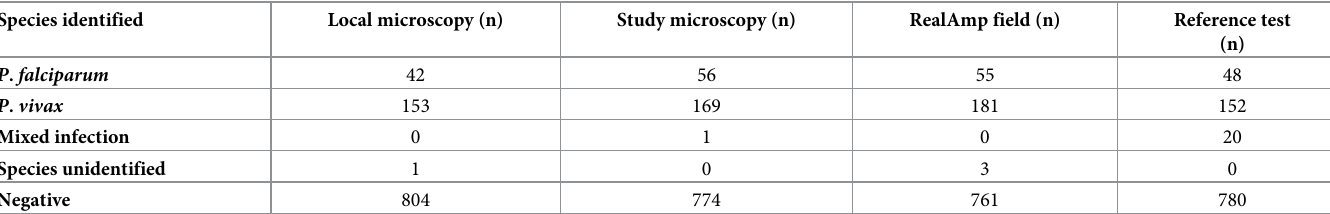
Table 1. Results of tests for malaria among samples collected in Cruzeiro do Sul, Acre state (n = 1,000). Species identified